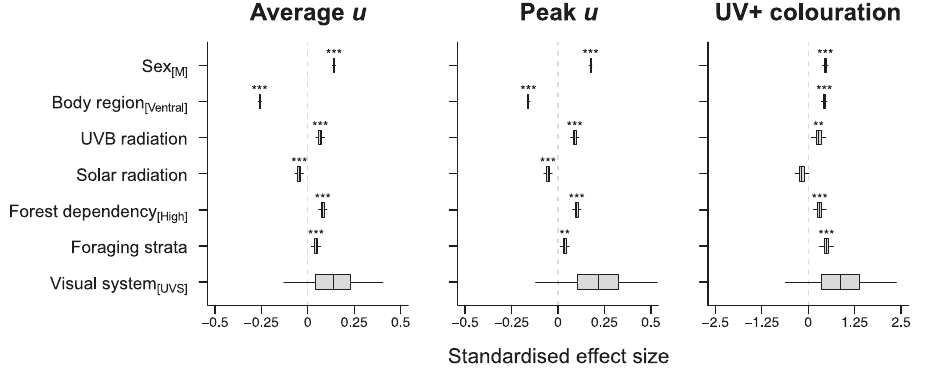
Fig.4|PredictorsofUVcolourationinpasserinebirds. Boxplotssummarisethe posterior marginal distributions for all fi xed-effects from Bayesian phylogenetic mixed models (two-sided tests, no adjustments for multiple tests) applied over a sampleof100phylogenetictrees.Boxwidthsrepresenttheinterquartilerange,the median is shown as a vertical line within each box, and whiskers denote the 95%